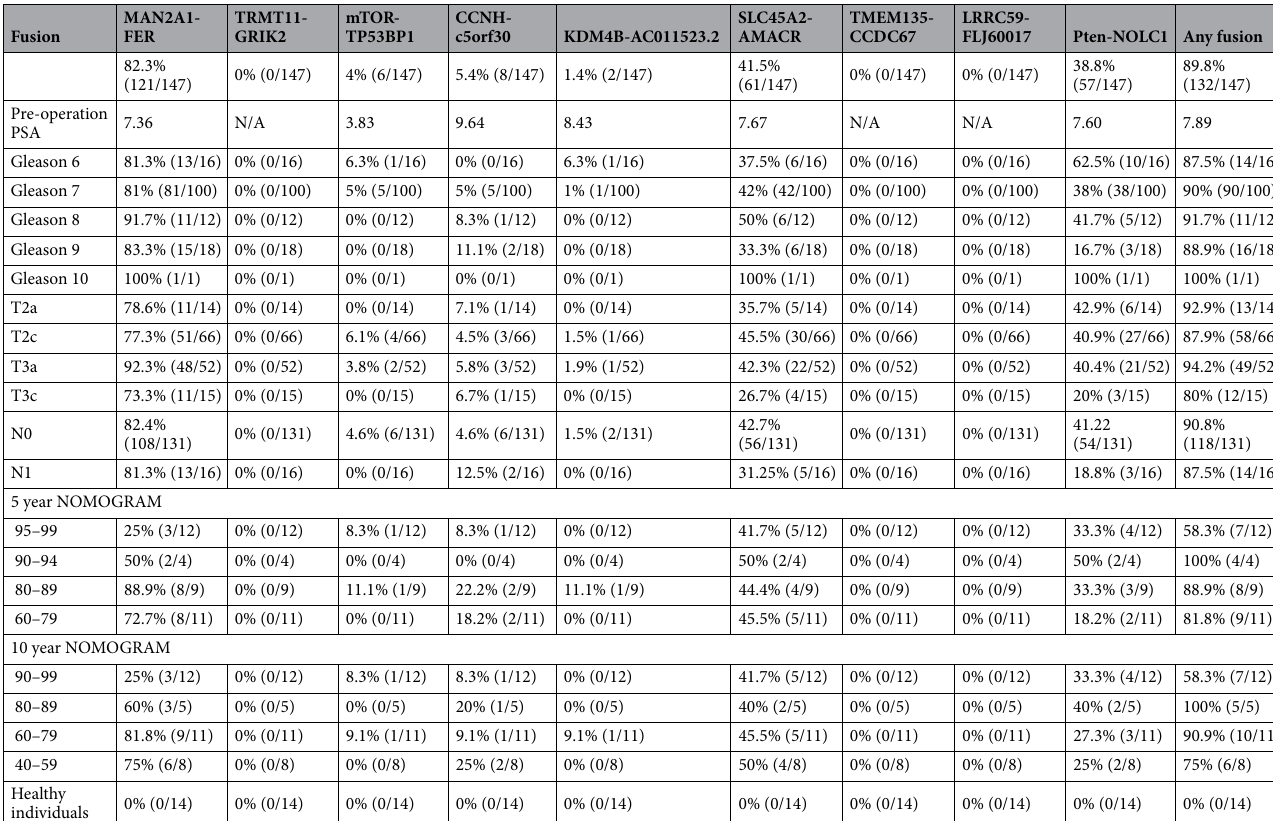
Table 1. Fusion transcripts detected in the blood samples of prostate cancer